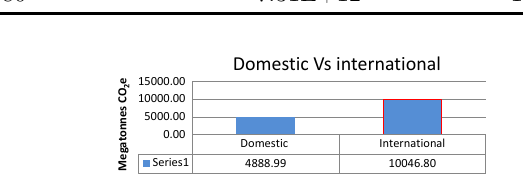
Fig. 2. Domestic and international emission for all shale gas fi elds – WA.